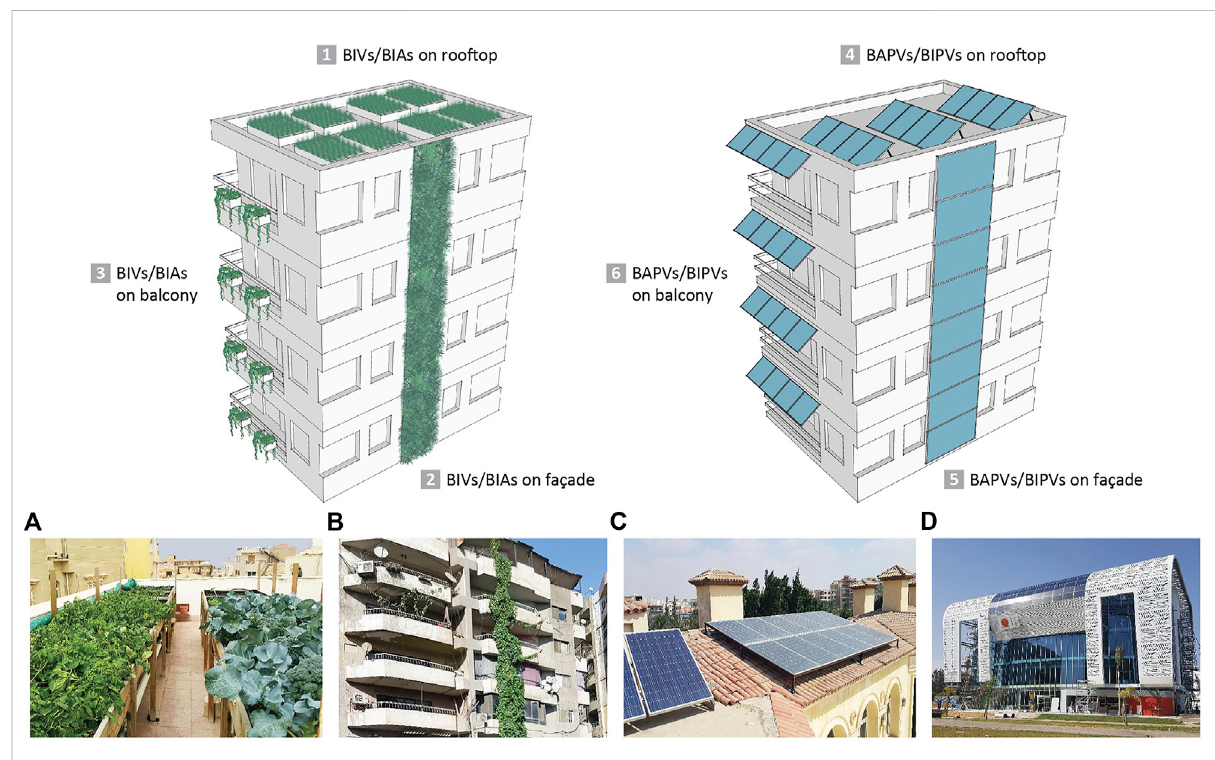
FIGURE 1 Productive Building Systems (PBSs) types (greening and solar energy systems) and their installation options onto building envelopes (rooftop, façade, and balcony). BIVs, Building-Integrated Vegetation systems; BIAs, Building-Integrated Agriculture Systems; BAPVs, Building-Applied Photovoltaics; and BIPVs, Building-Integrated Photovoltaics. (A) : BIAs on a rooftop in “ New Cairo ” , (B) : BIVs on a residential building façade in “ Haram ” , (C) : BAPVs on a rooftop in “ New Cairo ” , (D) : BIPVs on as a double skin façade in the “ Smart Village ” . Copyright of photos (A) – (C) : Mai Marzouk, photo (D) : Summit